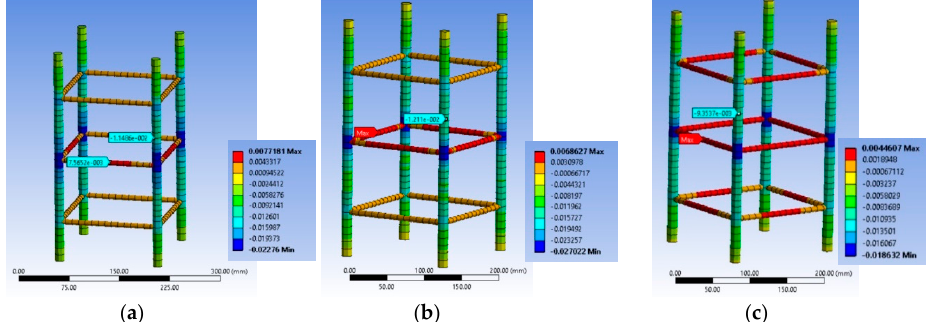
Figure 10. Variation of ε stirrup_max , ε long_mid and ε long_min for specimen ( a ) BS2C1C; ( b ) BS2C3C and ( c ) BS2C5C.